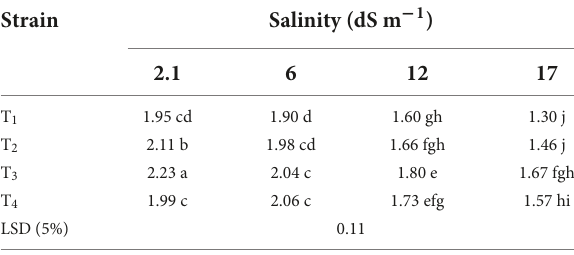
TABLE 8 Effect of inoculation with multi-strain bacterial consortium on K/Na of wheat at different salinity levels in a pot trial.